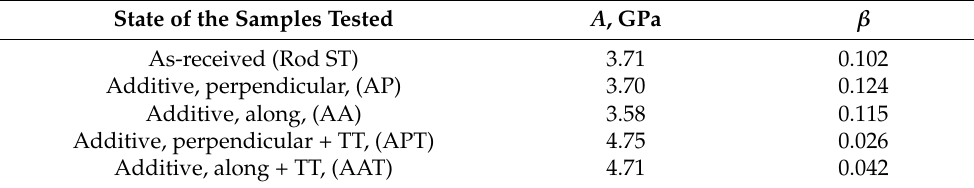
Table 5. The coefficient A and the power exponent β of the approximating function in Equation (7). State of the Samples Tested A , GPa β